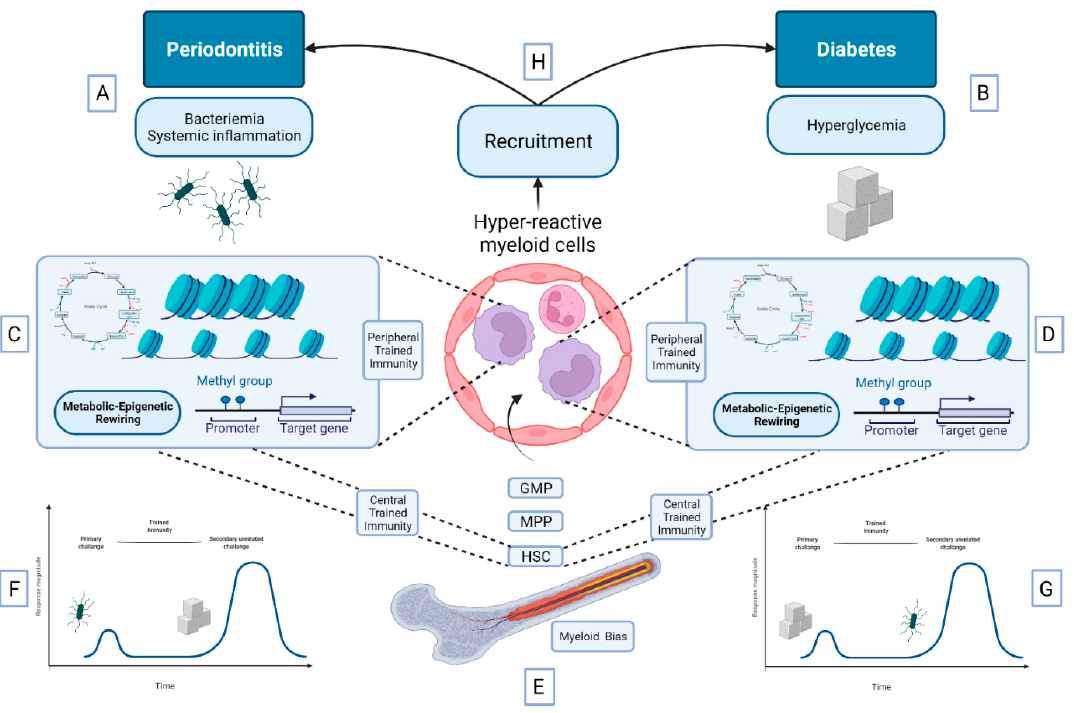
Figure 2. The hypothesis of trained innate immunity as the underlying mechanism of the bidirectional relationship between diabetes and periodontitis. (A) Periodontitis ‐ induced release of bacterial products and inflammatory cytokines as well as ( B ) diabetes ‐ induced hyperglycemia may induce metabolic/epigenetic rewiring of both peripheral myeloid cells (peripheral trained immunity) ( C , D ) and bone ‐ marrow precursors (central trained immunity) ( E ). This generates hyper ‐ active myeloid cells that can respond more effectively to a second unrelated challenge. ( F ) The graph shows that myeloid cells epigenetically trained by an earlier exposure to periodontitis ‐ related bacterial products may display an enhanced response to hyperglycemia and thus exacerbate diabetes ‐ related inflammation. ( G ) The graph shows that myeloid cells epigenetically trained by an earlier exposure to hyperglycemia may display an enhanced response to bacterial products and thus exacerbate periodontitis ‐ related inflammation. ( H ) Regardless of whether hyperactive myeloid cells are first affected by either periodontitis or diabetes, trained immunity can have a deleterious effect on both conditions and may provide a rationale for their bidirectional relationship. HSC (hematopoietic stem cells), MMP (multipotent progenitors), GMP (granulocyte/macrophage progenitors). 6. Conclusions and Perspective Observational studies provided convincing evidence of a bidirectional relationship between periodontitis and DM. Moreover, intervention trials suggest that periodontal treatment ameliorates both circulating inflammatory markers and HbA1c in patients with DM; however, evidence that successful periodontal treatment can reduce the risk/incidence of type 2 DM is still lacking. Further, large clinical trials should be undertaken to assess the effect of periodontitis treatment on DM and vice versa. Recent studies in experimental animals suggest that drugs that are currently used for the treatment of DM2, such as metformin, sulfonylureas, and GLP ‐ 1 receptor agonists, may also have direct beneficial effects in periodontitis by decreasing inflammation [48,51,52], bacterial dysbiosis [49,50], and bone loss and by enhancing bone formation [47,226]. This suggests that, beyond lowering blood glucose levels, anti ‐ diabetic drug may also have pleiotropic effects of potential relevance in the context of periodontitis.